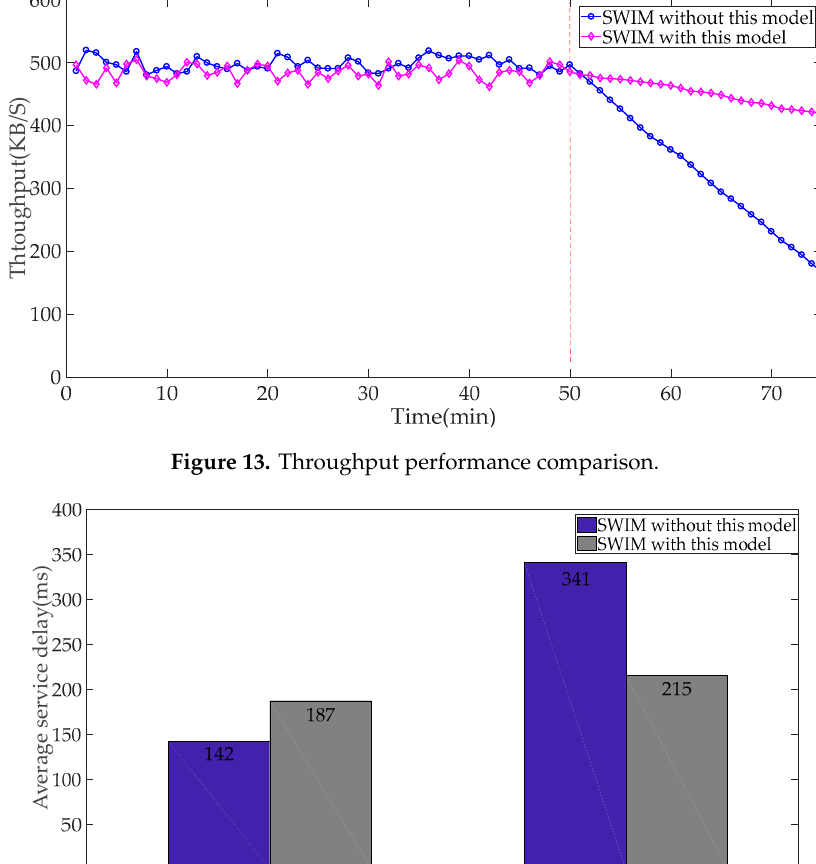
Figure 13. Throughput performance comparison.